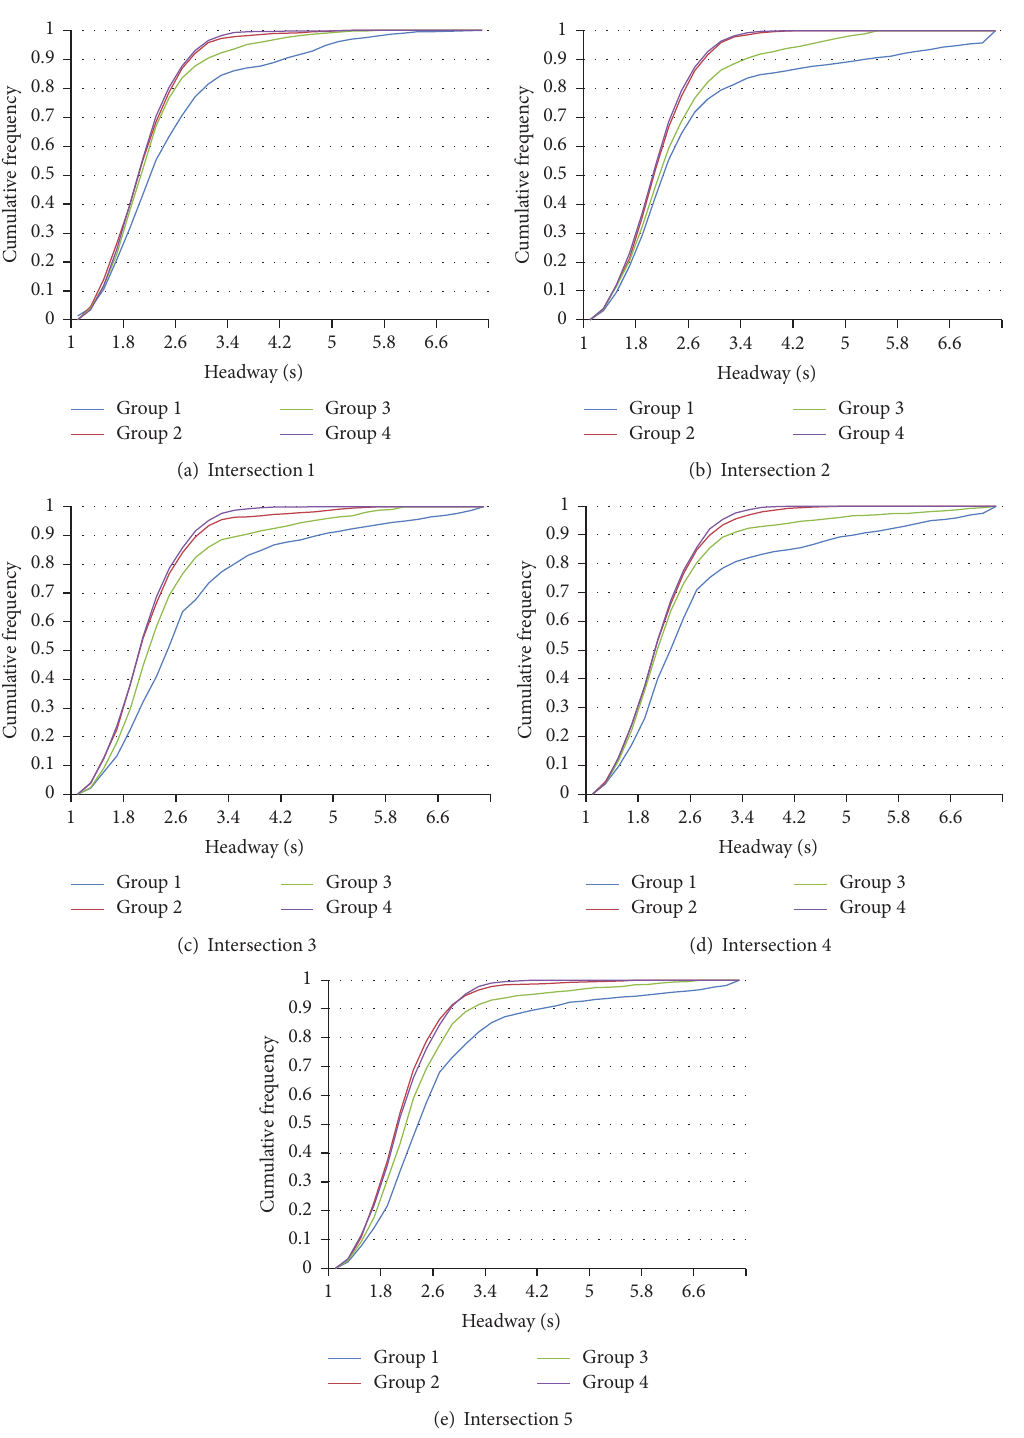
Figure 4: Distribution of